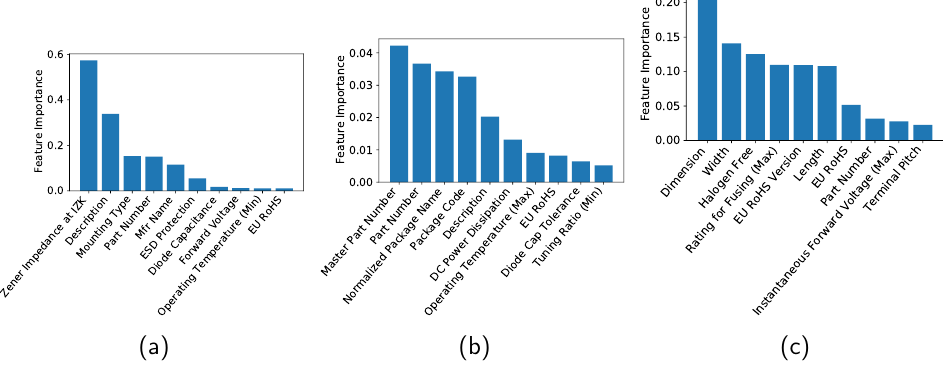
Figure 6. Feature importance of ( a ) Zener diodes, ( b ) varactors, and ( c ) bridge rectifier diodes when a random forest is applied.